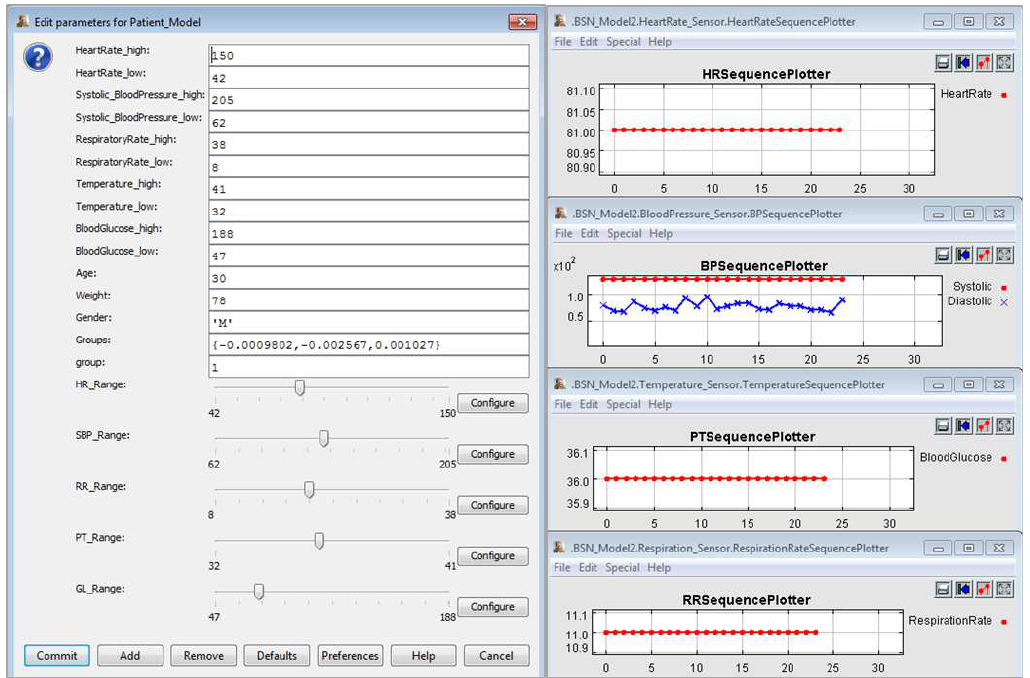
Figure 19. Simulation of an MCPS Model Using the ICU Patient